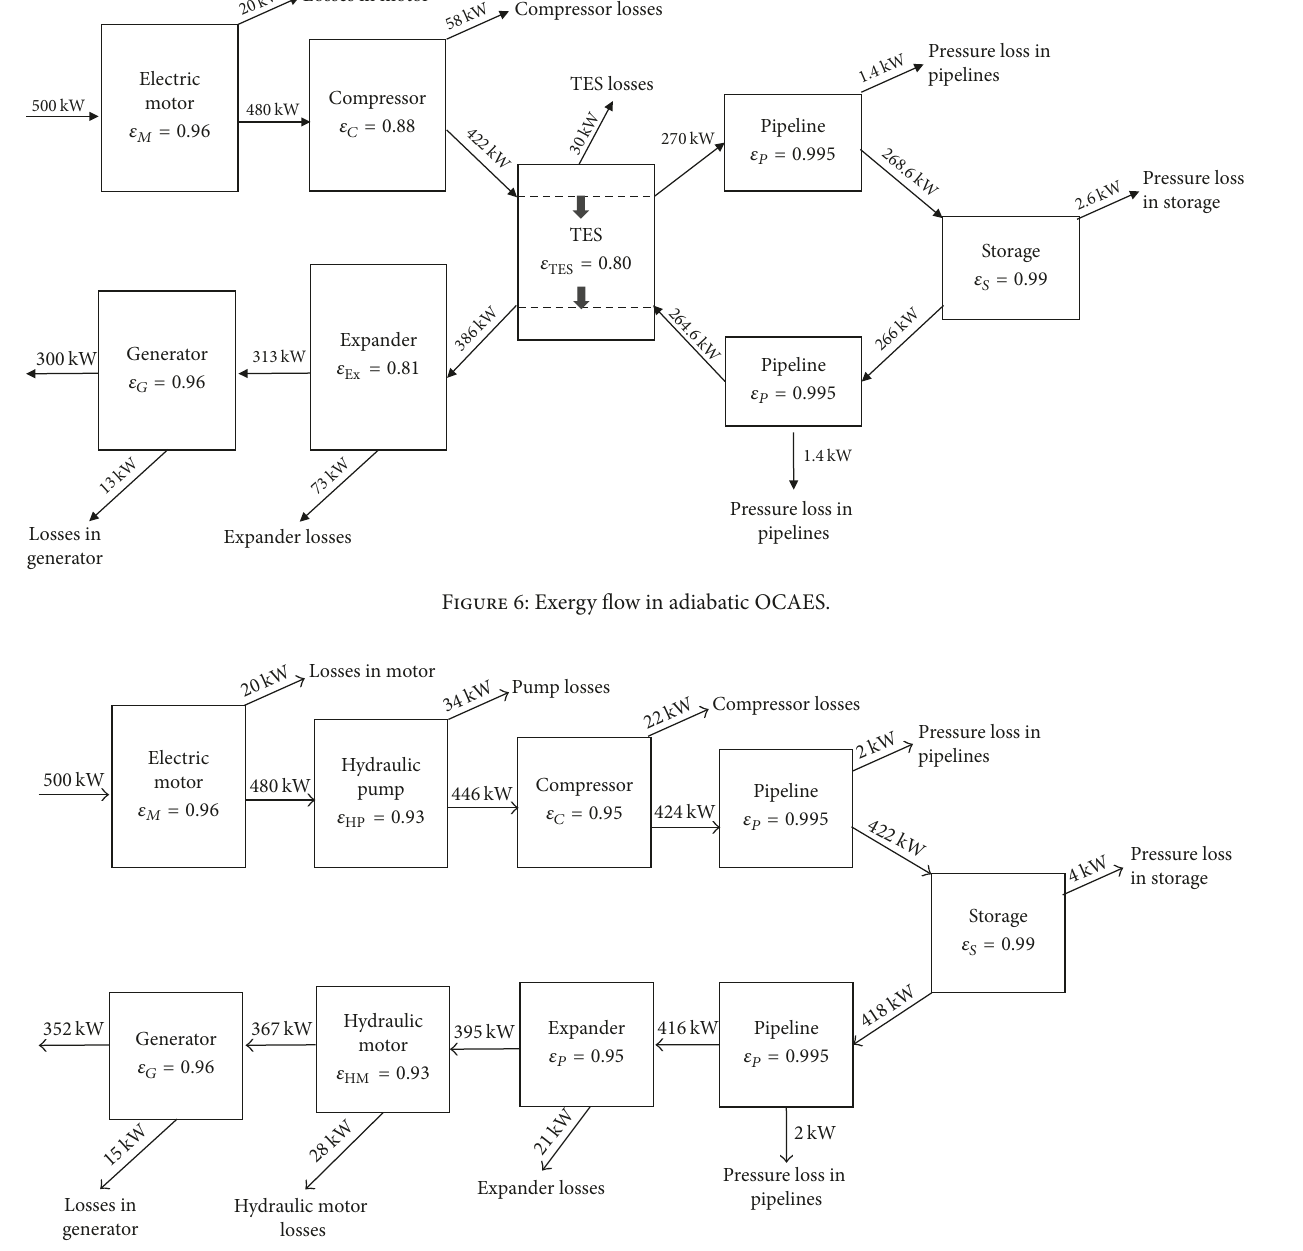
Figure 7: Exergy flow in isothermal